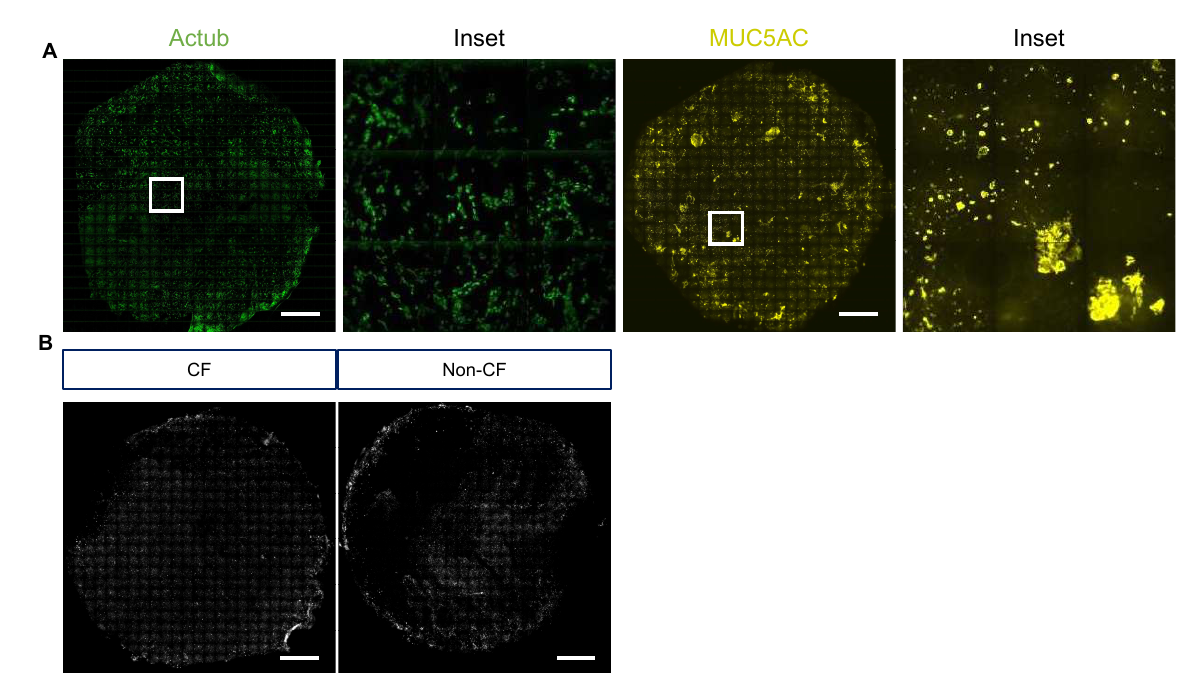
Figure 6. Representative stitched tiled images (25 × 25) of air-liquid interface cultures. ( A ) Acetylated tubulin (Actub) and MUC5AC with magnified insets (3 × 3). ( B ) SARS nucleocapsid protein (NP, grey) in SARS-CoV-2-infected air-liquid interface (ALI) cultures. A 20 × /0.5 objective. Scale bars: 1 mm.